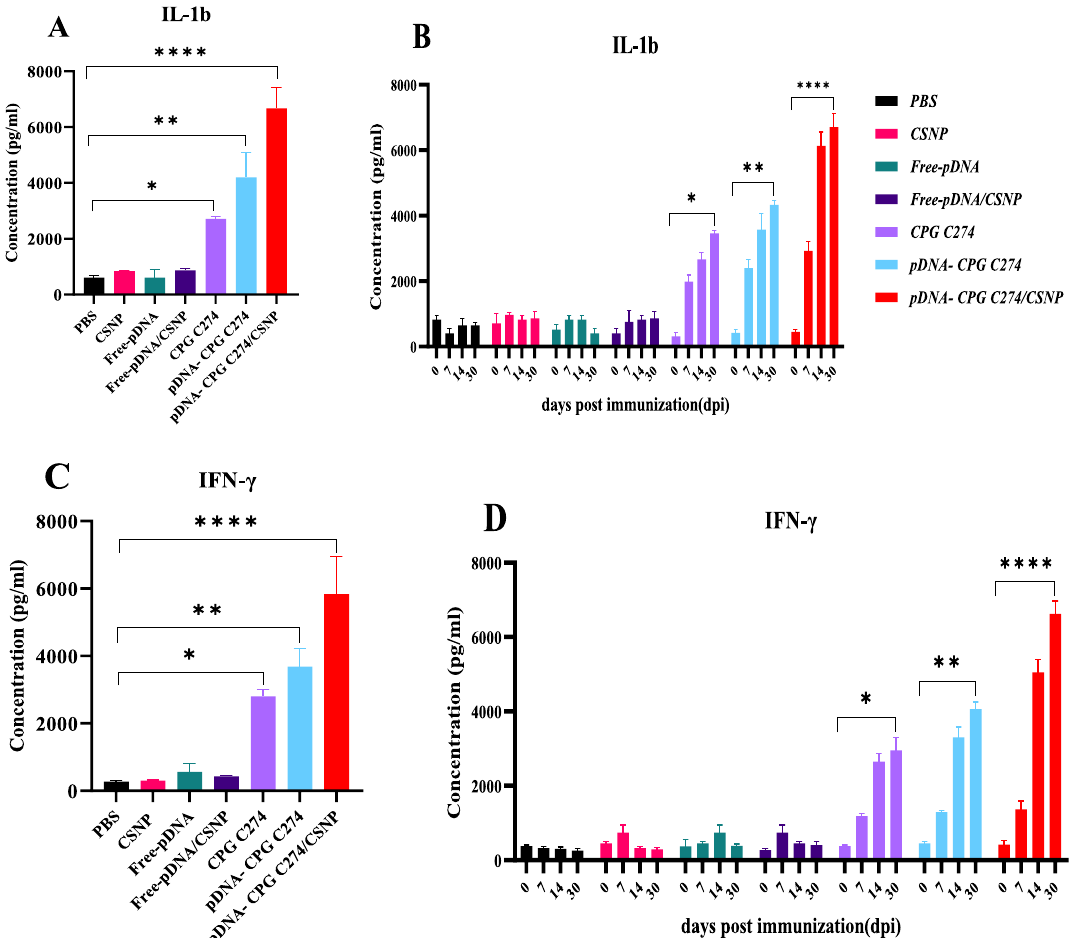
Fig. 5 Cytokine levels in the sera. Groups of female Balb/c mice ( n with pDNA and CSNP on day 0, 7, 14, and 30. pDNA‑ CPG C274/CSNP increased concentrations of IL‑1β ( A ) and IFN‑γ ( C ) in serum. The highest levels of IL‑1β ( B ) and IFN‑γ ( D ) were observed on day 30. Data in the plot present the mean ****p ≤